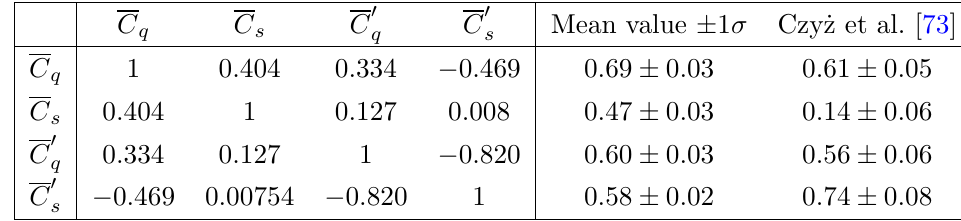
Table 9 . Correlation matrix for the (cid:17) (cid:0) (cid:17) 0 mixing parameters, mean values and marginal standard deviations according to our best (cid:12)t analysis. These results are compared to the corresponding values from ref. [73].